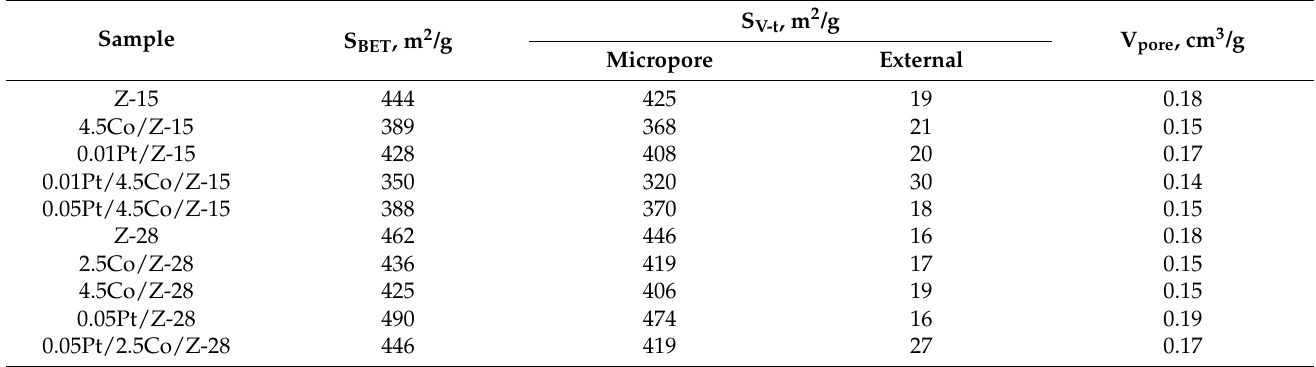
Table 2. The textural properties of parent and Pt- and Co-modified zeolites.